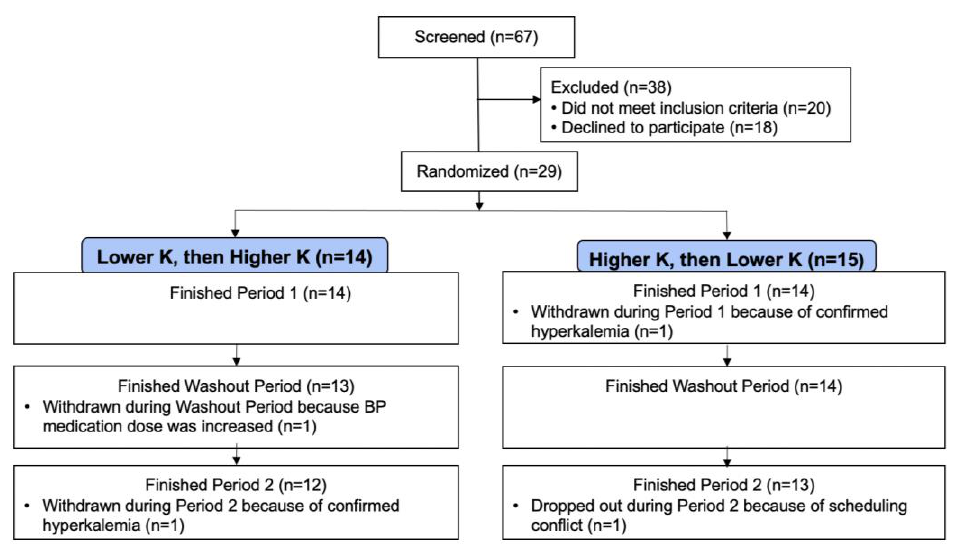
Figure 1. Consort diagram of the CKD-K trial.